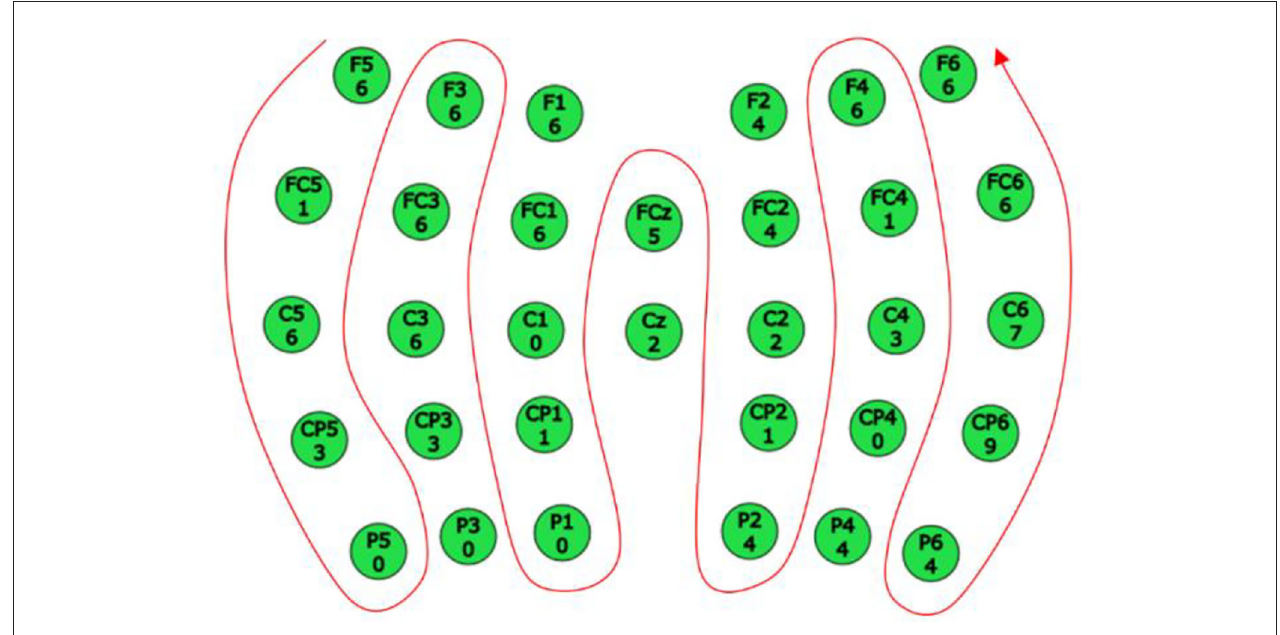
FIGURE 2 | The rearranged order of the selected 32 channels.